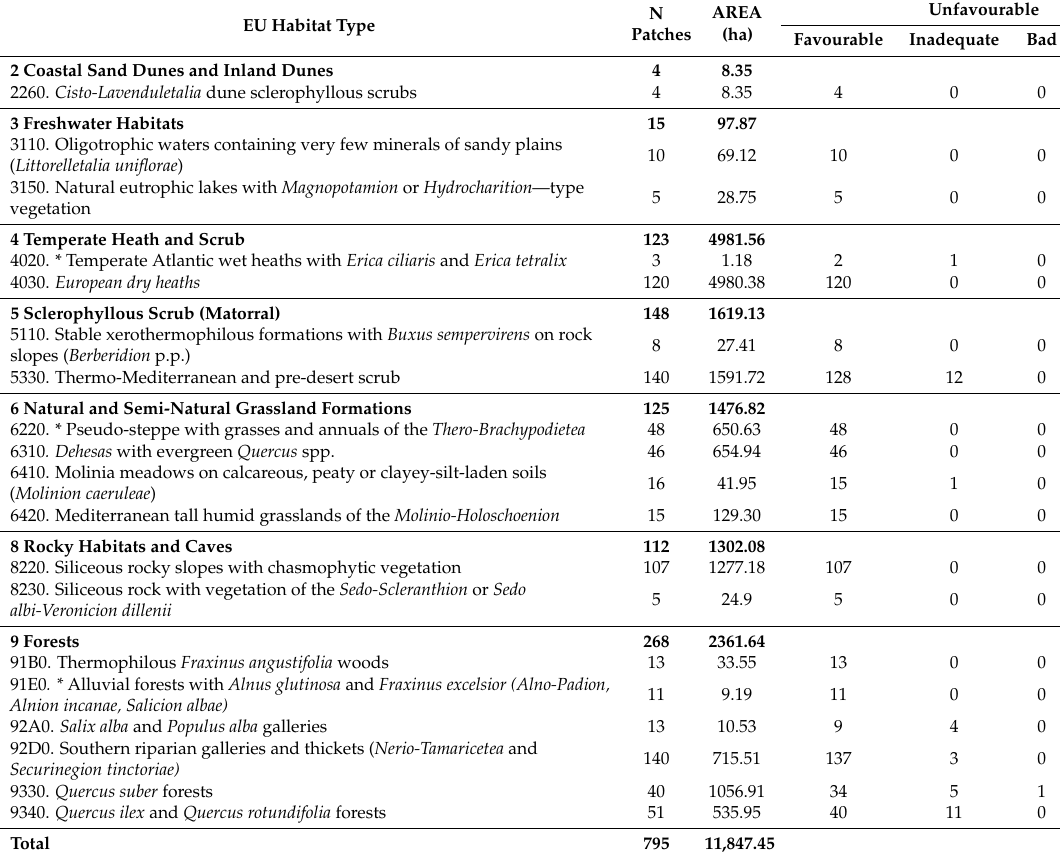
Table 5. Area of the different types of HCI in the conservation areas of the Spanish province of Huelva and number of patches and summary of the assessment of all habitats managed by Ence in the province of Huelva. Sorted by type and subtype as established in Annex I of the Habitats Directive. The habitats that appear with an asterisk (*) are considered priorities for the EU. Total number of patches and area are expressed in